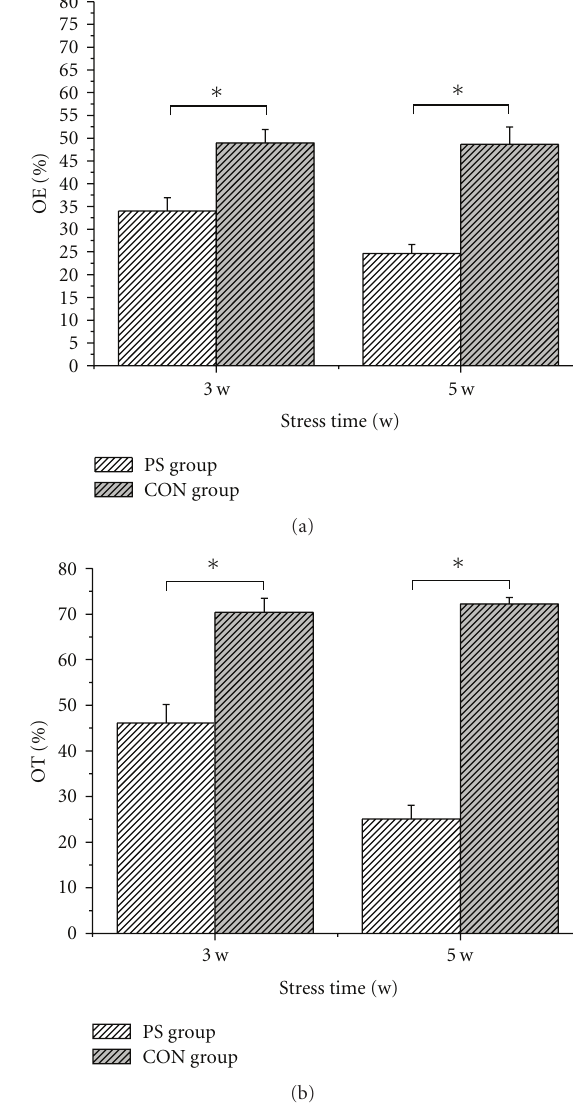
Figure 3: Measurement of rat behaviors in the elevated plus-maze test. Comparison of the percentage of open arm entries (OE%) (a) and the percentage of time spent in the open arms (OT%) (b) in the EPM test among groups. Data were expressed as X ± SE and analyzed in eight rats from each group ( ∗ P < .05, PS group versus CON